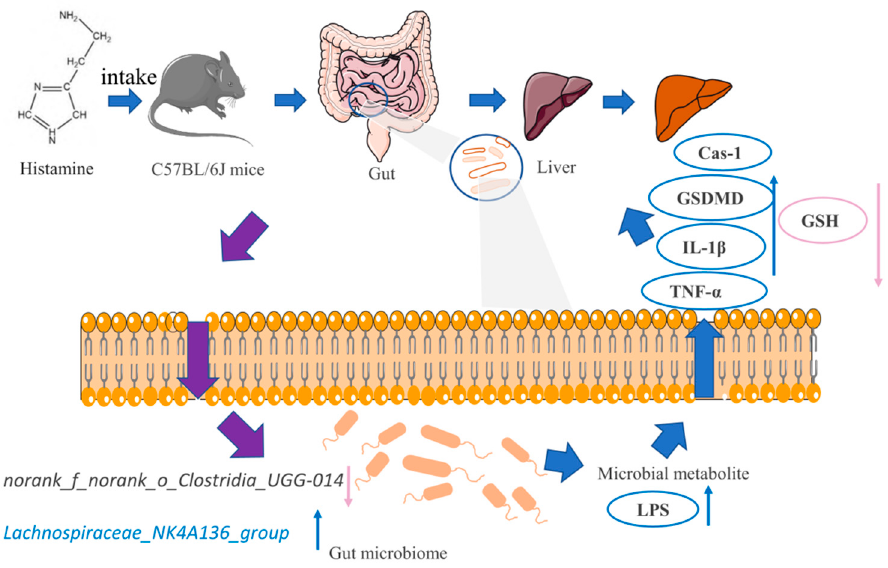
Figure 7 . A schematic model shows the mechanism of liver pyroptosis caused by oral histamine. Gut microbiota, oxidative stress, and inflammation are all affected. microbiota, oxidative stress, and inflammation are all